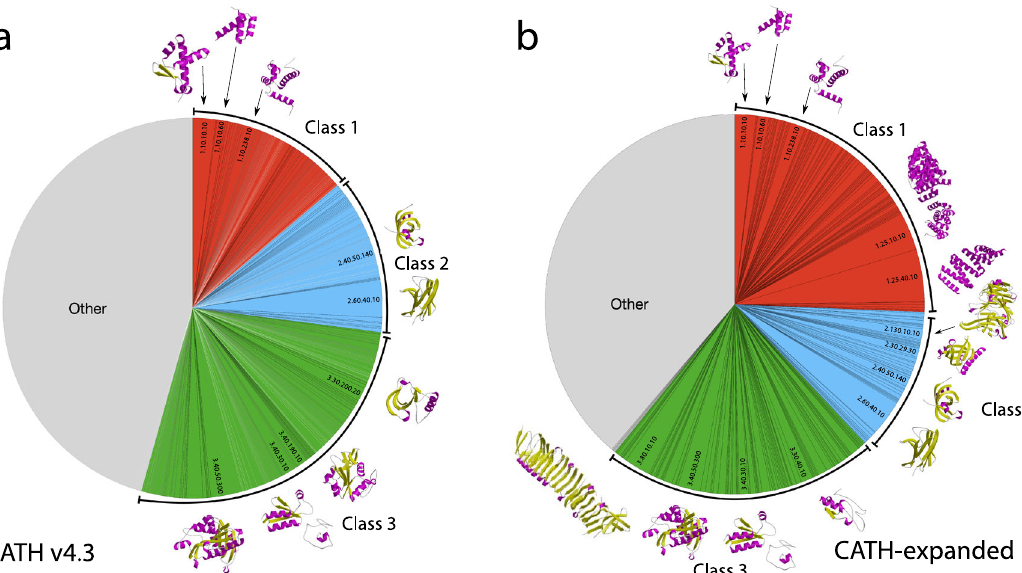
Fig. 9 Expansion in structural diversity in CATH by predicted AlphaFold structural models. a Distribution of structural cluster sizes coloured by CATH class in CATH v4.3 and b expanded by AlphaFold structural